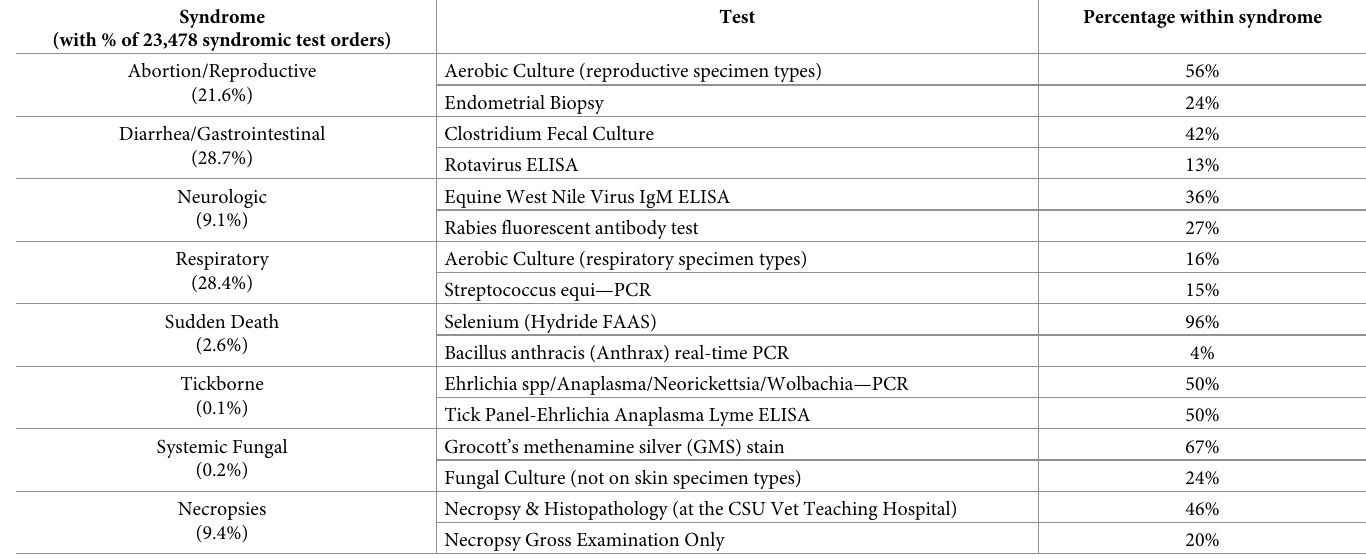
Test Percentage within syndrome